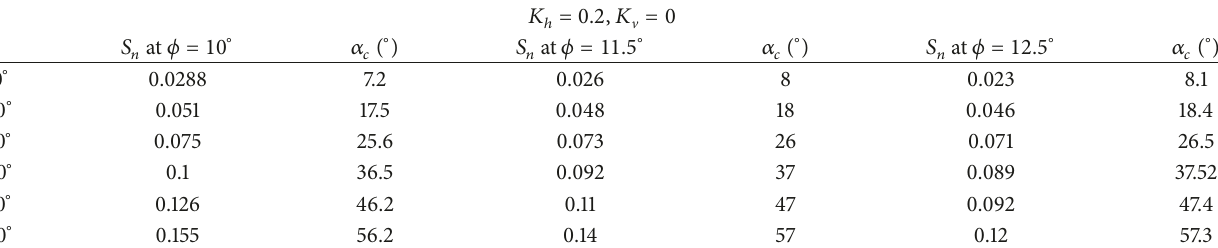
Table 6: Critical angle and stability number of slope made up of soil + 10% saw dust